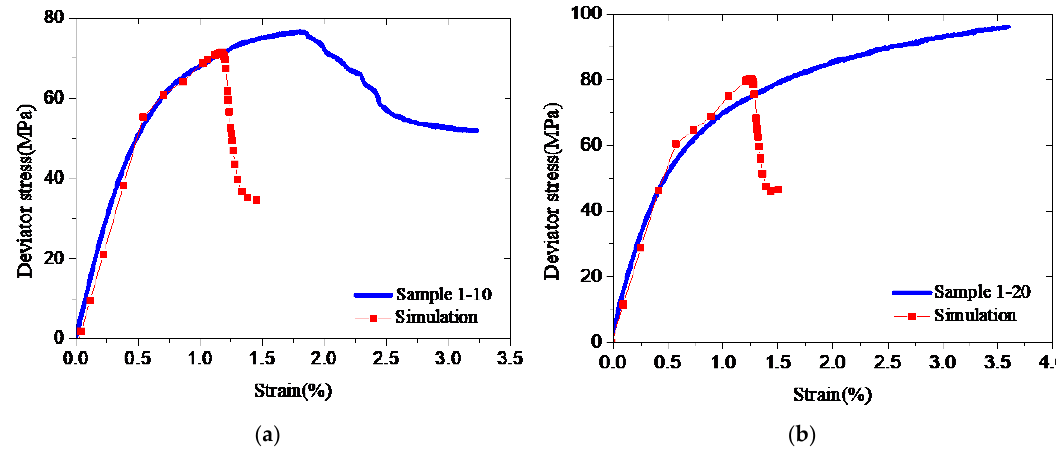
Figure 6. Simulations and triaxial test data for Sample 1. ( a ) Sample 1-10; ( b ) Sample 1-20.